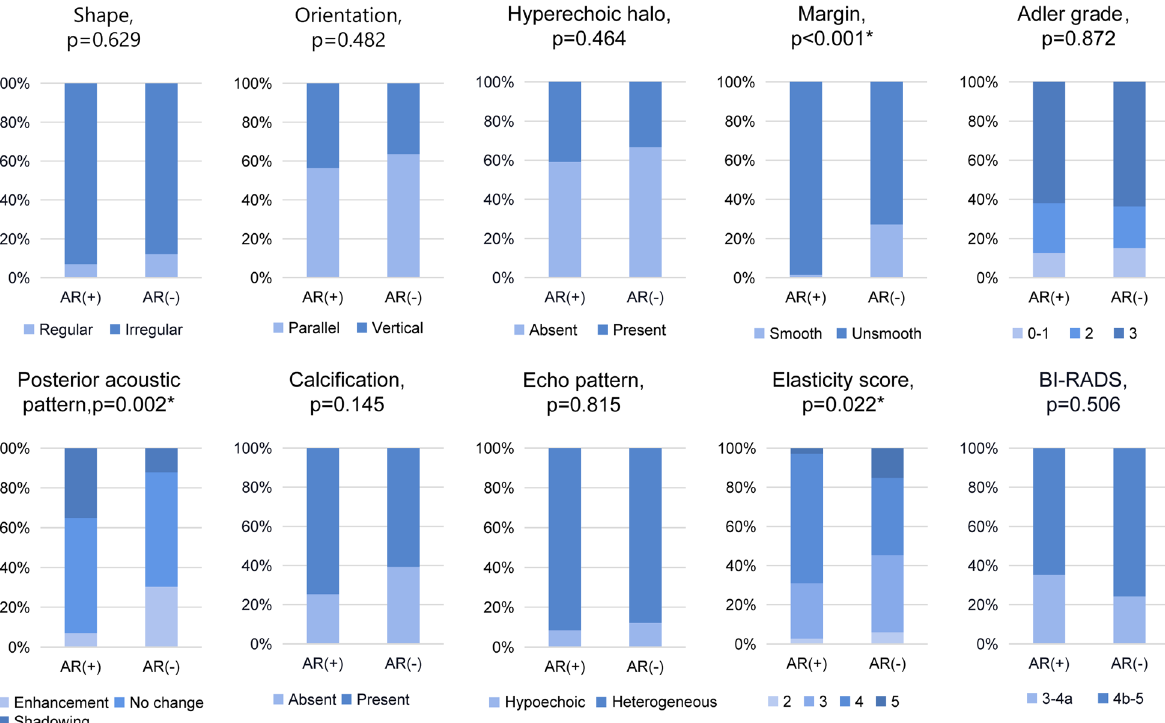
Fig. 3 Comparison of ultrasound characteristics between AR Data System; AR , androgen receptor; * indicates p <